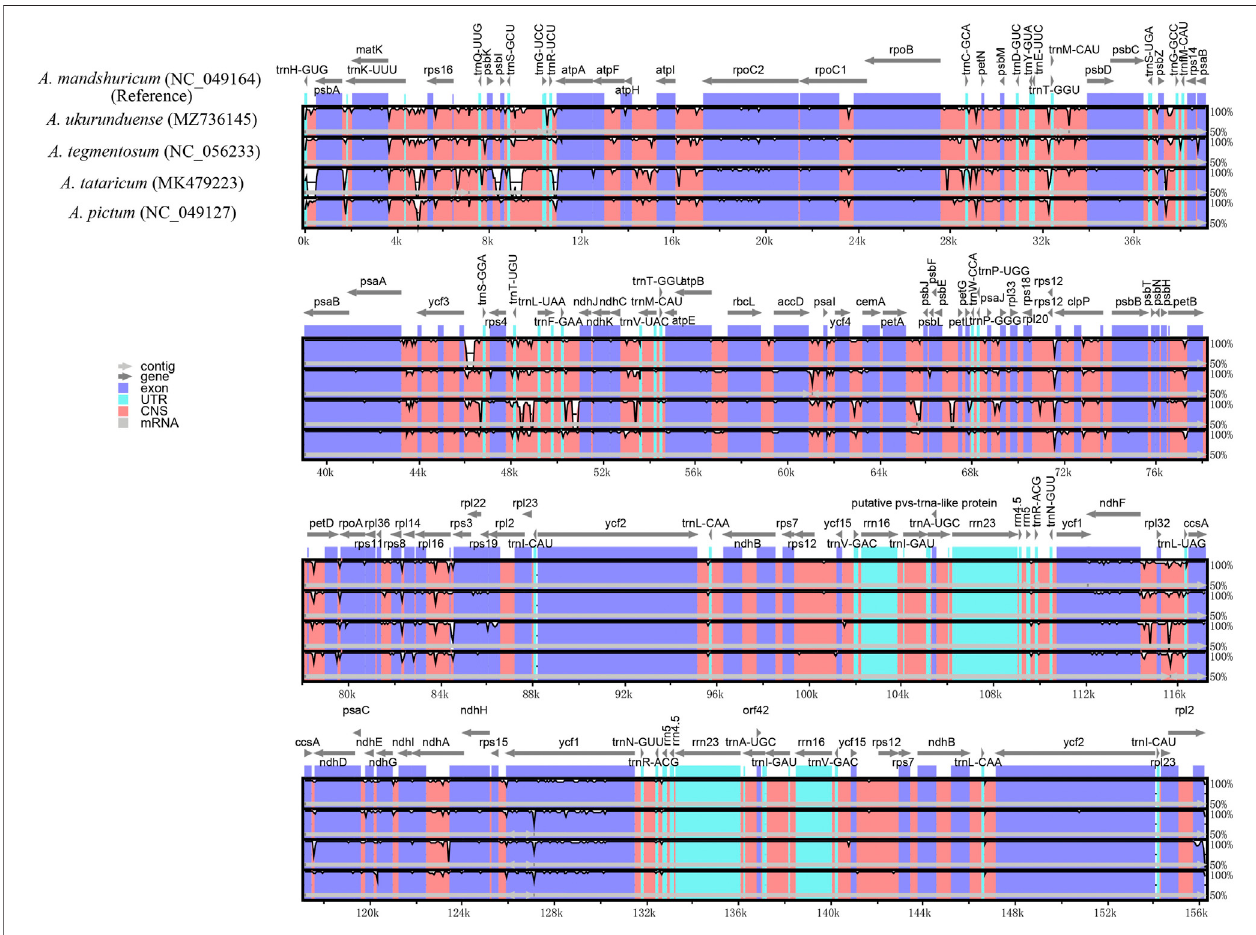
FIGURE8| Visualized alignments of fi ve cpgenomesof Acer using mVISTA,with A.mandshuricum asthe reference. Thehorizontalaxis indicates the fi vespecies ’ cp genome of the alignment. The vertical scale represents the percentage identity, ranging from 50 to 100%.